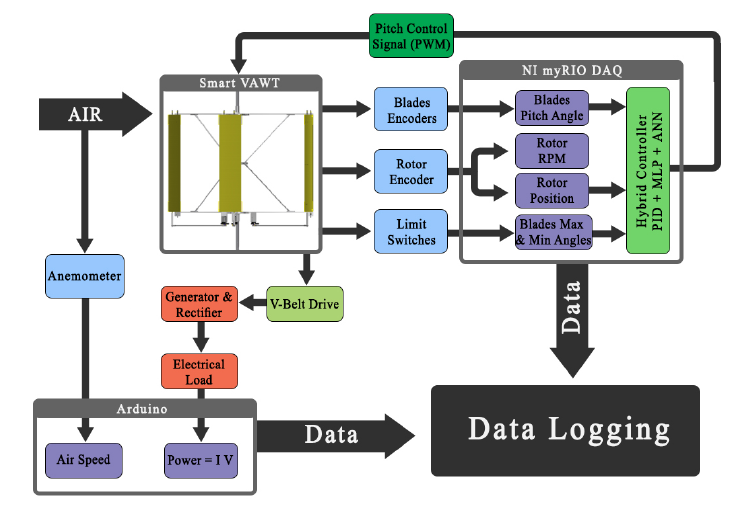
Figure 7. Blade pitch control system and data logging.